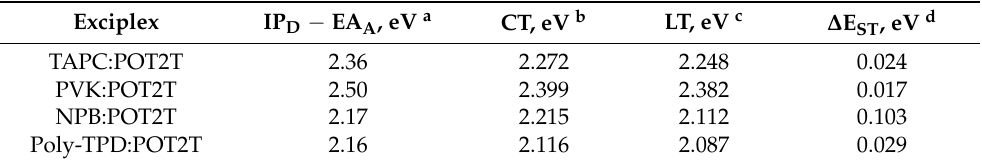
Figure 3. ( a ) Photoluminescence (PL) spectra of exciplex blended films; ( b ) energy levels of investigated donors and acceptors. Table 2. Photophysical Properties of Investigated